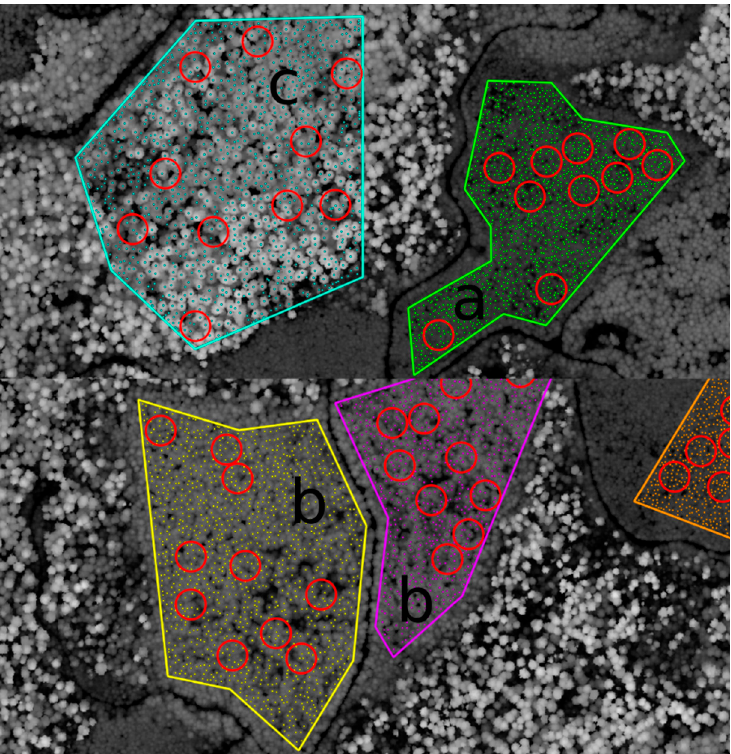
Figure 5. Random allocation of the 1000-m 2 plots used to assess crown segmentation accuracy: ( a ) young stand, ( b ) mature stand, and ( c ) old stand. The red circles show the location of the plots used for accuracy assessment.